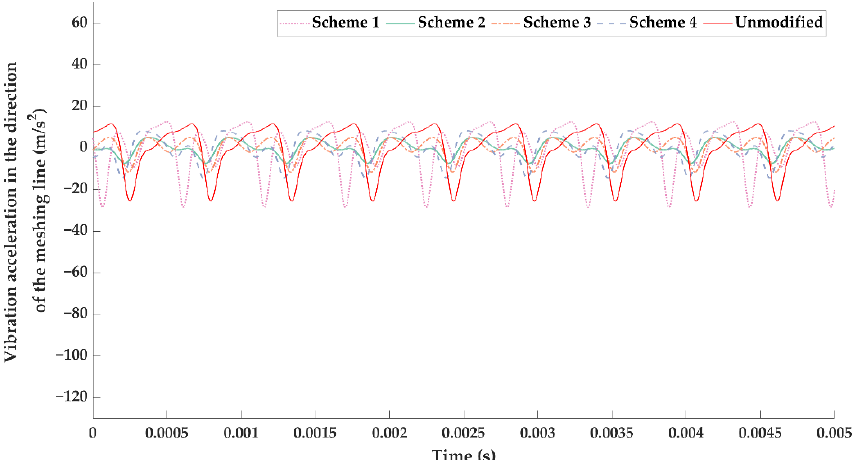
Figure 25. Vibration acceleration in the direction of the gear meshing line at a load of 350 N·m.